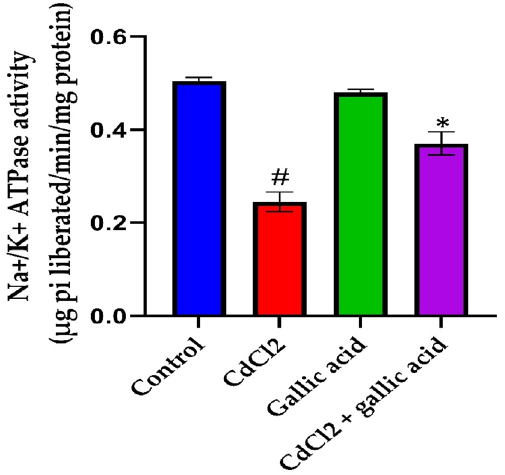
Figure 8. Impact of gallic acid and cadmium on the activities of membrane bound ATPases in the cerebrum of control and experimental rats. The data is represented as mean ± SD (n = 5). # Significant at p < 0.05 compared to the control; *Significant at p < 0.05 compared to the CdCl 2 only group.